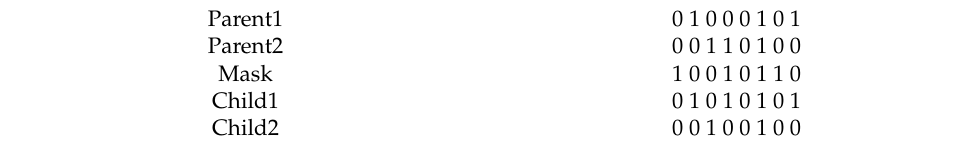
Table 2. Uniform crossover operation.